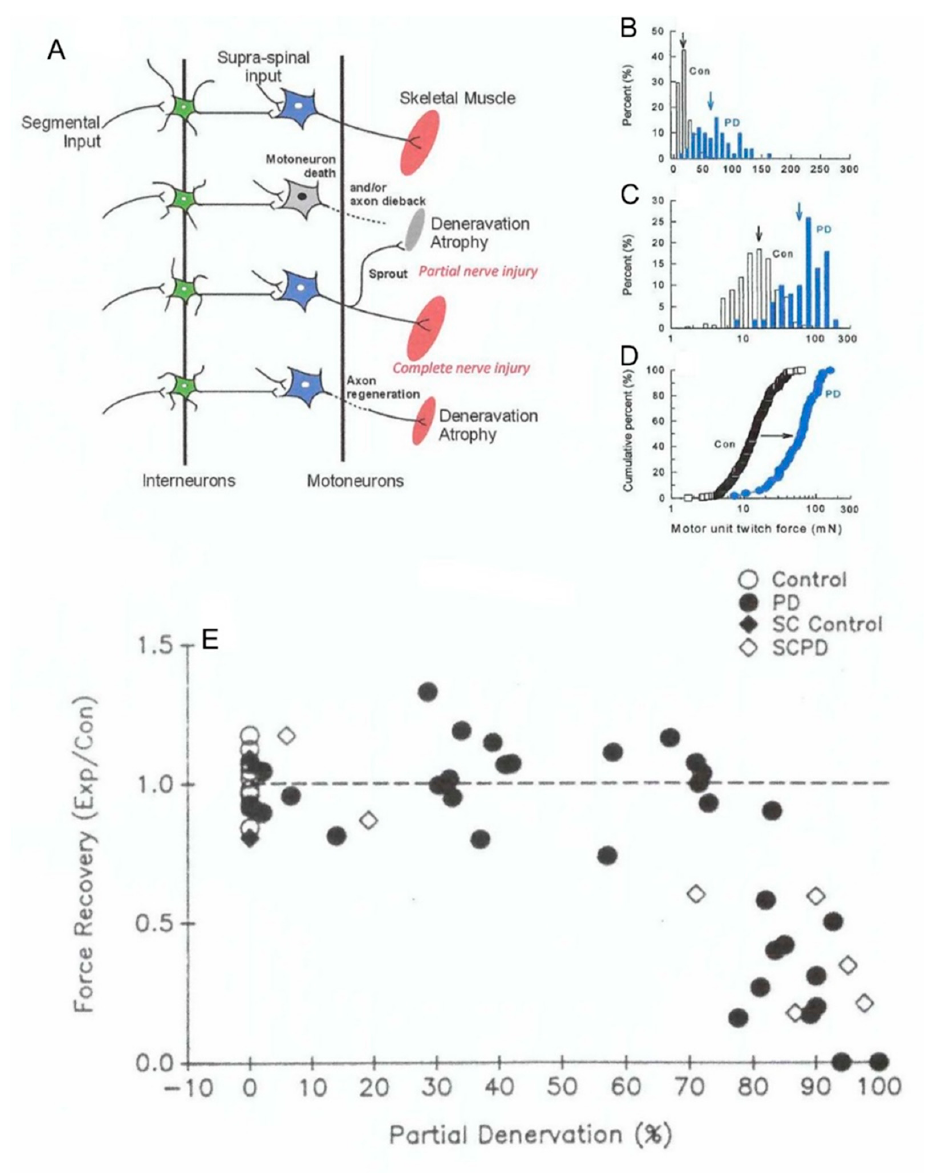
Figure 7. Motor unit enlargement after partial denervation of muscles. Figurative illustration of muscle denervation, reinnervation after complete nerve injury, and compensatory sprouting after